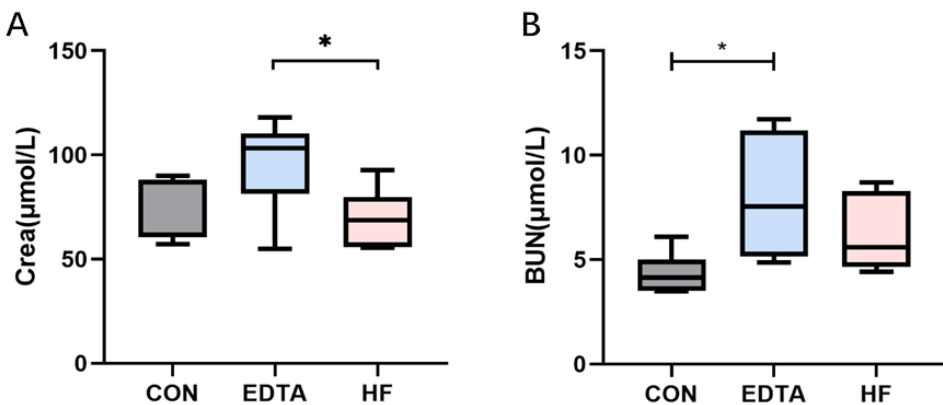
Figure 6. Levels of Crea and BUN in the serum of each group detected by automatic biochemical analyzer. ( A ) Level of Crea in the serum of each group. ( B ) Level of BUN in the serum of each group. CON: control group, EDTA: experimental group, HF: recovery group. Statistically significant differences are indicated by * p < 0.05.